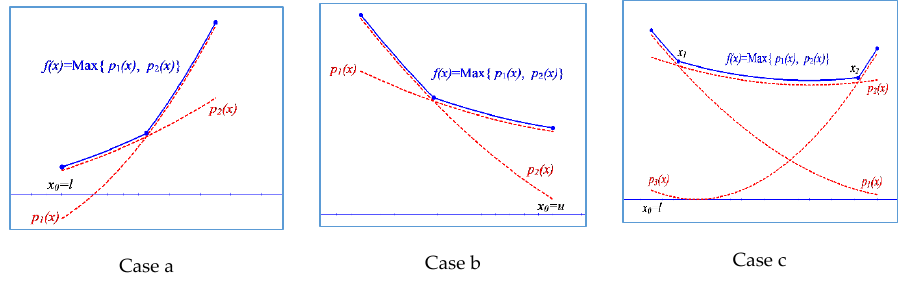
Figure A1. Graphical representation of the three cases.